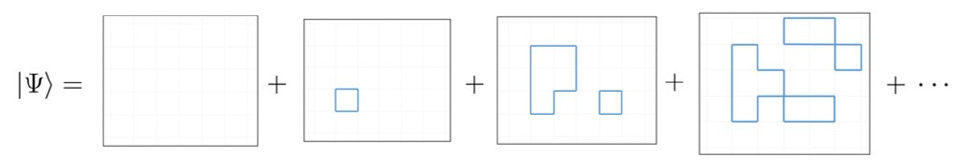
Figure 6 . The ground state wavefunction of a Z 2 gauge theory is an equal-weight superposition of all closed string con(cid:12)gurations on the links of a lattice. Equivalently, we can label the state via plaquette variables, in terms of which the wavefunction looks like a direct product